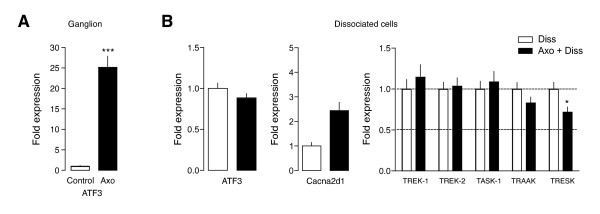
Positive injury markers in dissociated and axotomized neurons. A. Upregulation of injury marker ATF3 in neurons axotomized in vivo (***p < 0.001; n = 4 animals). B. ATF3 shows similar levels of expression in Diss. and Diss+Axo neurons (n = 3 independent dissociated cultures). Notice that a similar fold change is obtained when normalizing with Diss. expression levels, implying that expression levels of Diss. neurons had increased to levels in axotomized neurons. Cacna2d1 and TRESK expression also followed the same pattern (compare data in Fig 3B and Fig 1B) although a significant decrease in TRESK is still seen in Diss+Axo neurons compared to Diss. neurons only (*p < 0.05; n = 4 independent experiments).